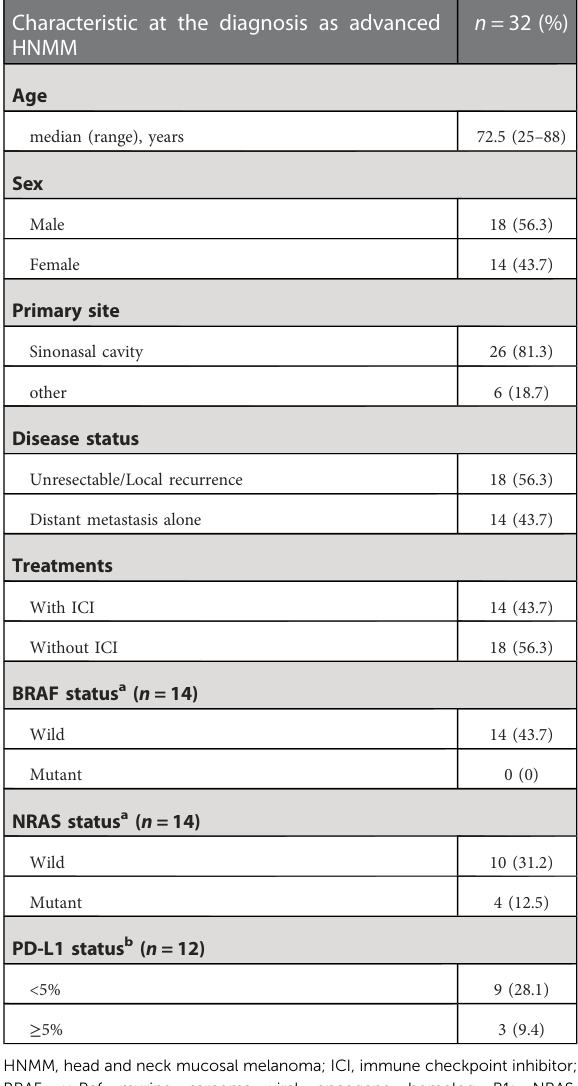
TABLE 2 Characteristics at the diagnosis as advanced HNMM ( n =32). Characteristic at the diagnosis as advanced